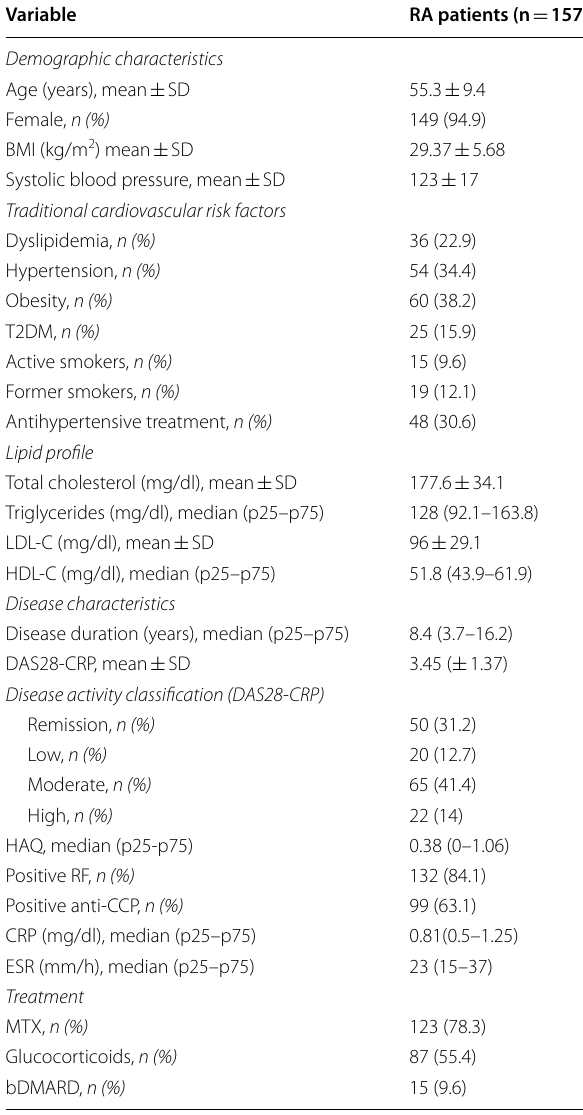
Table 1 Demographic and disease characteristics of all study subjects